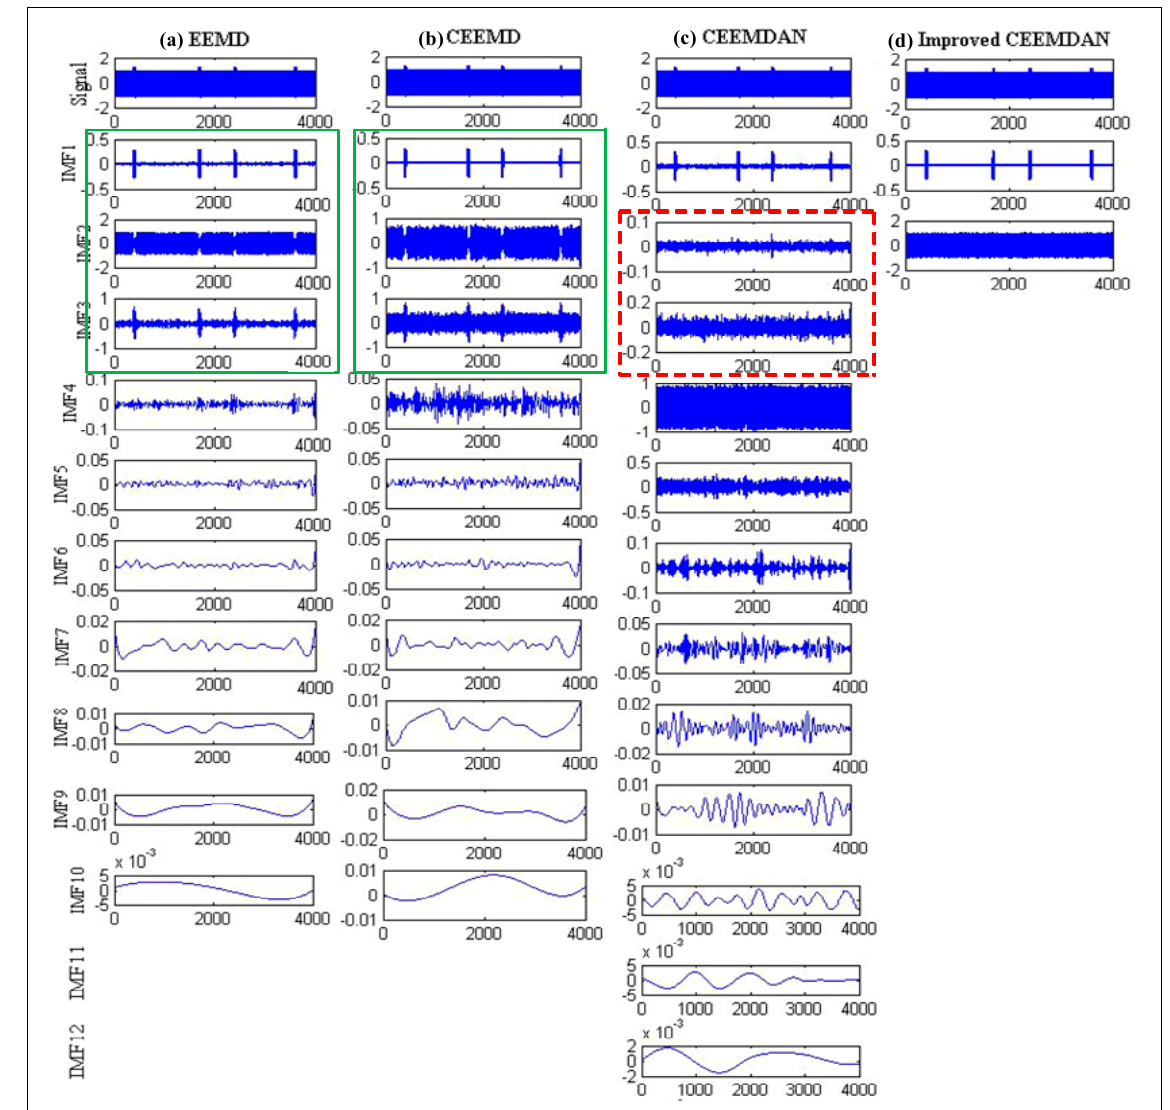
Figure 3. Decomposition results of ( a ) EEMD, ( b ) CEEMD, ( c ) CEEMDAN, and ( d ) ICEEMDAN (AR = 0.3, SFR = 2.35).